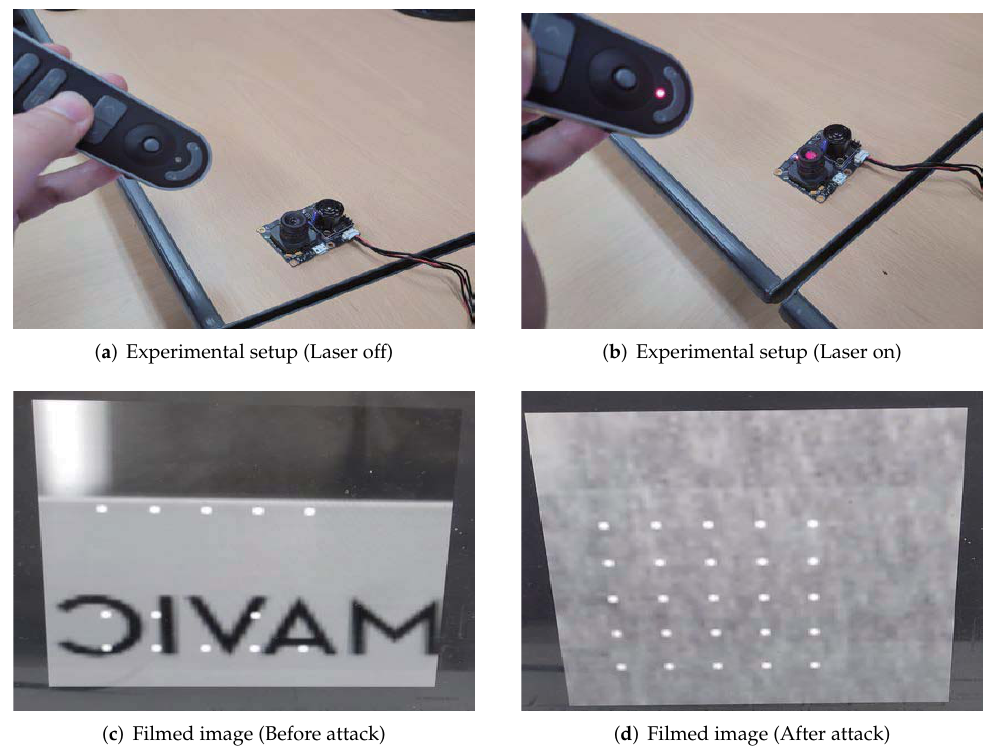
Figure 12. Experimental setup for non-RF IEMI on optical flow. ( a ) Laser attack off. ( b ) Laser attack on. ( c ) Filmed image before the laser attack was applied. To easily indicate changes, an object with written letters was placed in front of the camera. ( d ) Filmed image when the laser attack was applied. A distorted image was